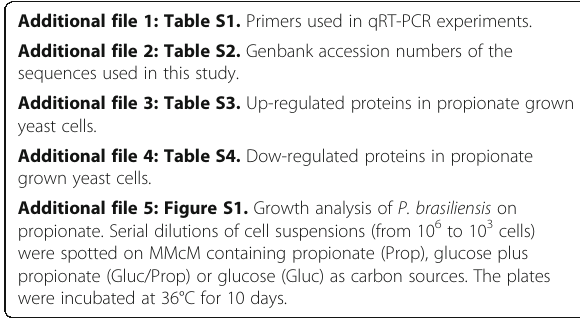
Additional file 1: Table S1. Primers used in qRT-PCR experiments. Additional file 2: Table S2. Genbank accession numbers of the sequences used in this study. Additional file 3: Table S3. Up-regulated proteins in propionate grown yeast cells. Additional file 4: Table S4. Dow-regulated proteins in propionate grown yeast